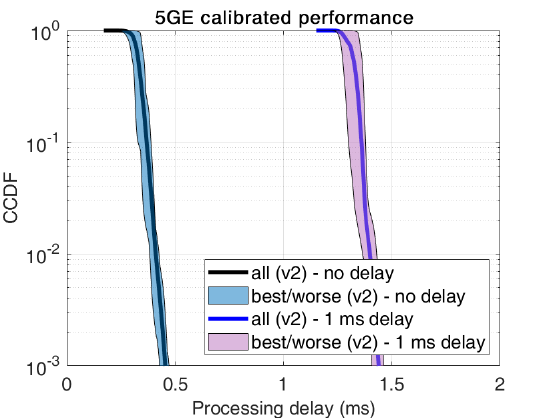
Figure 6. CCDF of the processing delay introduced by the 5GE device in operational conditions.